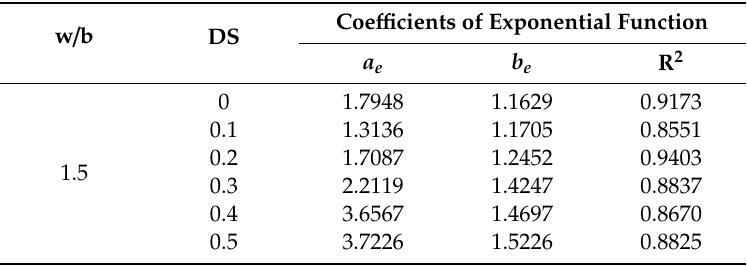
Table 5. Exponential function coe ffi cients of the surface resistivity prediction model based on the DS